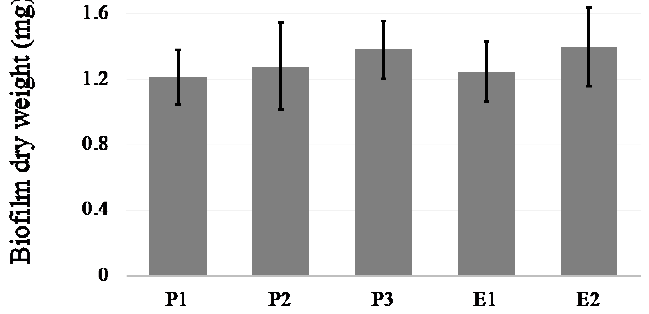
Figure 3. Biofilm quantification of C. parapsilosis.